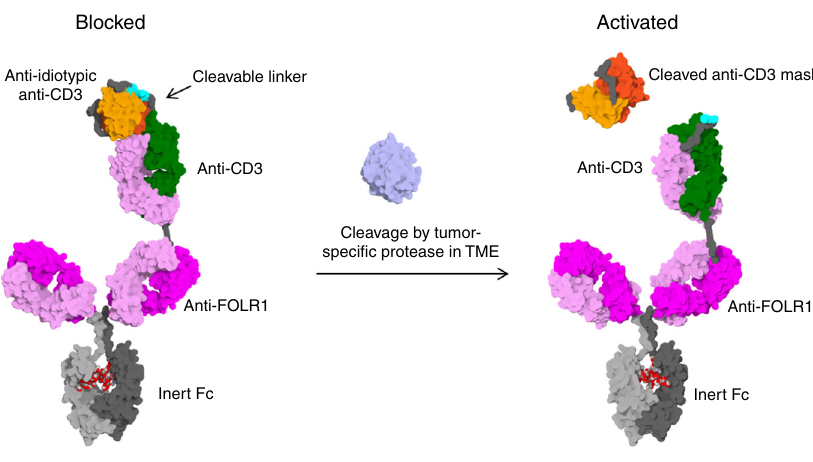
Fig. 1 Mode of action of protease-activated FOLR1-TCB. On the left panel, the anti-CD3 Fab is blocked by an anti-idiotypic anti-CD3 scFv and thus cannot activate T cells against FOLR1-expressing cells. On the right panel, the linker containing a tumor-speci fi c protease site has been cleaved and the anti-CD3 moiety is active leading to lysis of FOLR1-expressing cells. The fi gure shows an idealized representation of the Prot-FOLR1-TCB before (left) and after (right) cleavage at the matriptase cleavage site (cyan). The model is based on the full-length IgG crystal structure with PDB ID 1hzh. The protected anti- CD3 ε Fab was modeled based on the crystal structure of an idiotype-anti-idiotype Fab complex structure with PDB ID 1iai. The catalytic domain of matriptase (crystal structure with PDB ID 1eax) is shown for reference (gray). Visualized with Biovia Discovery Studio 17R2 and arranged with GIMP. TME tumor